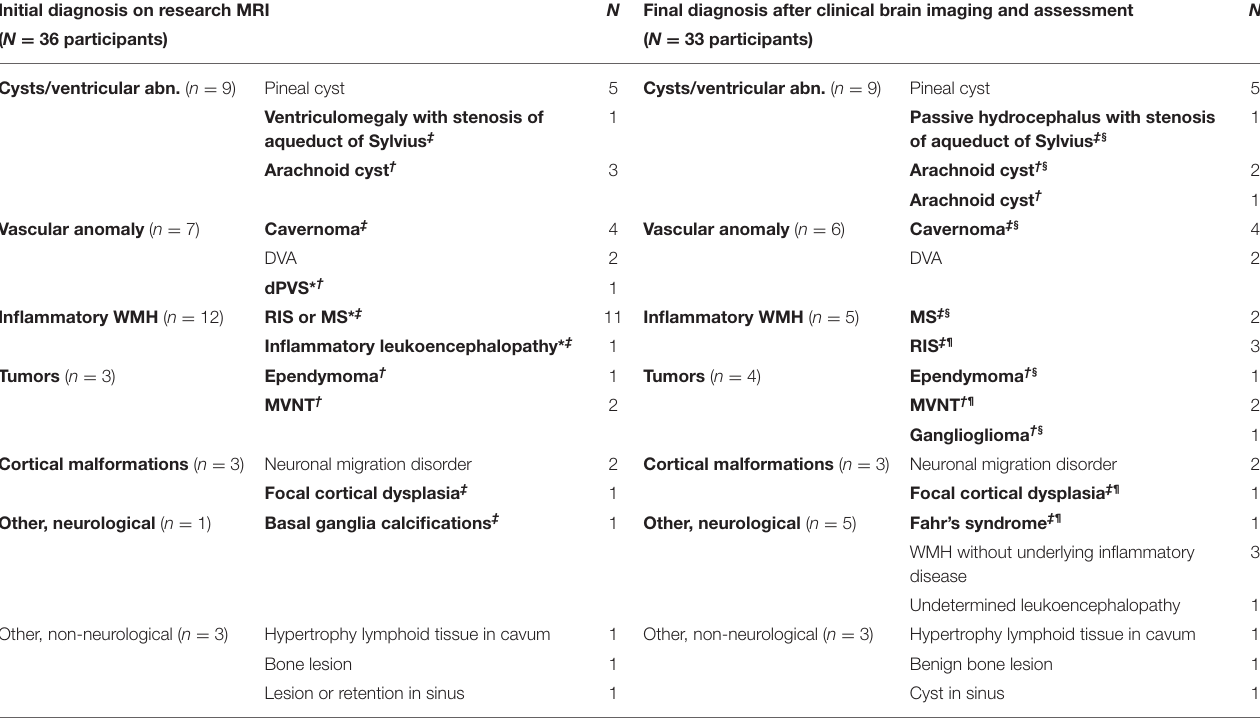
TABLE 3 | Diagnosis’ classification of the 38 incidental findings (IFs) of the 36 participants requiring medical referral according to etiology. Initial diagnosis on research